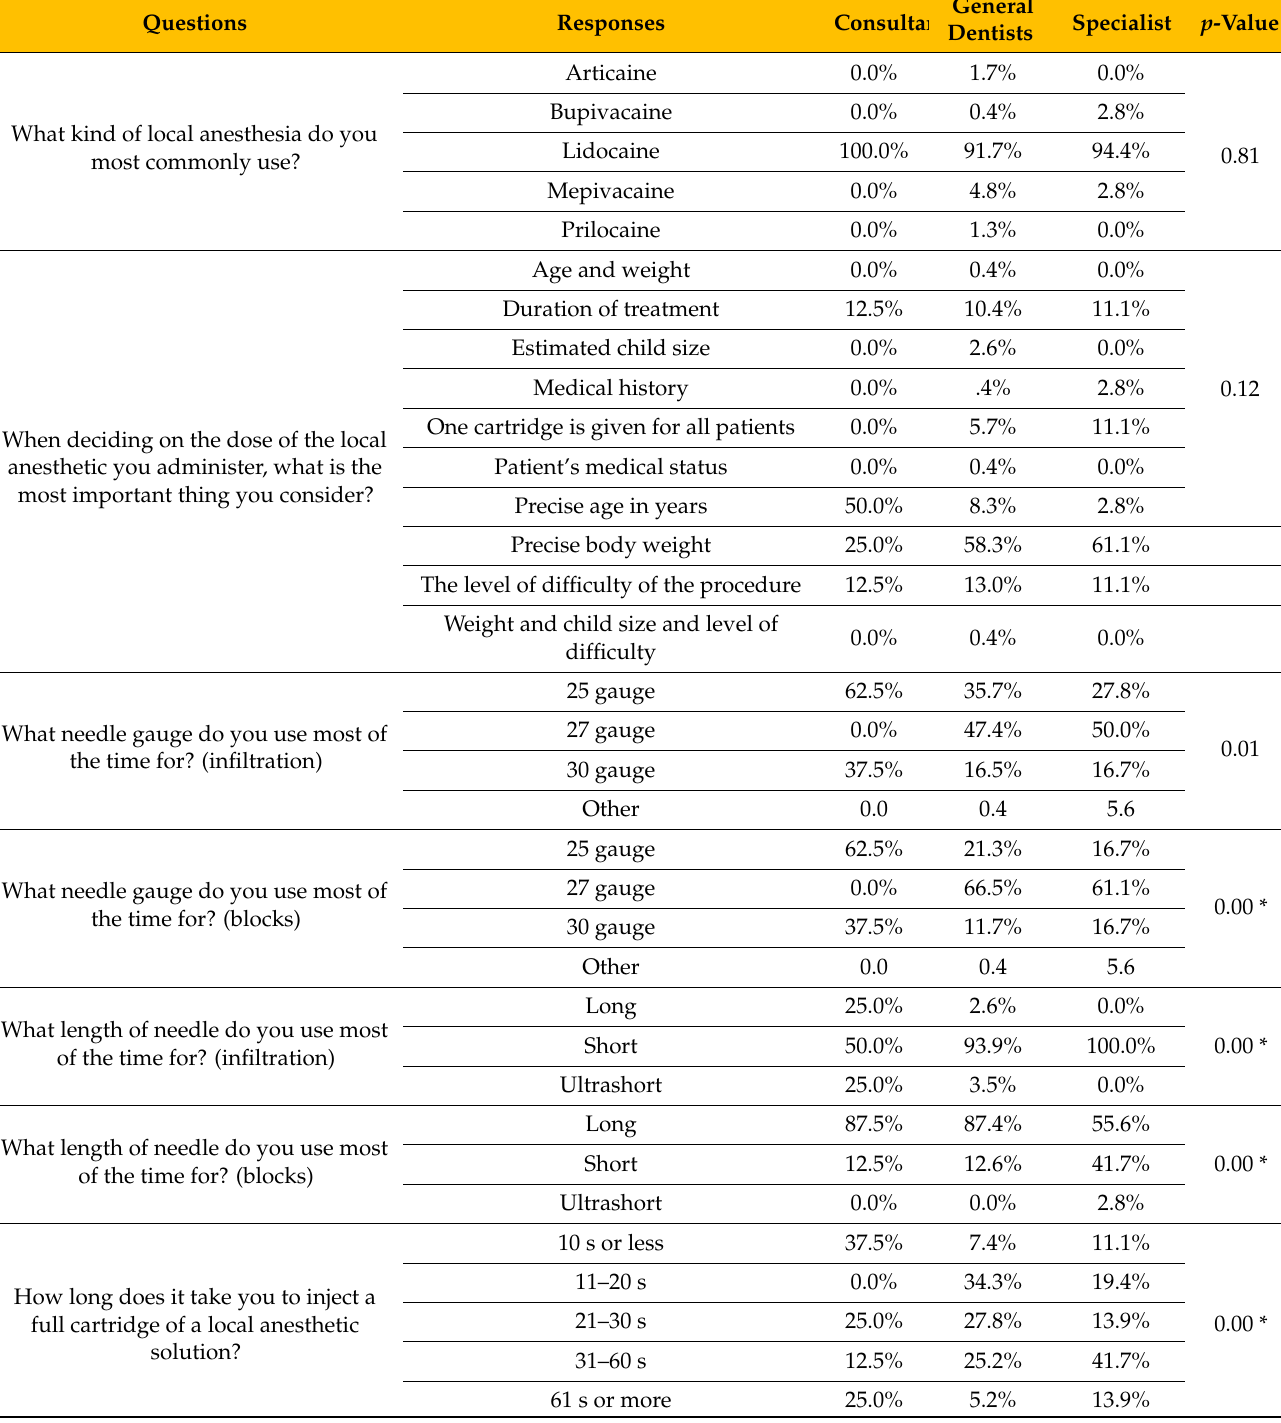
Table 3. Perceptions of local anesthetics among Saudi dental practitioners based on